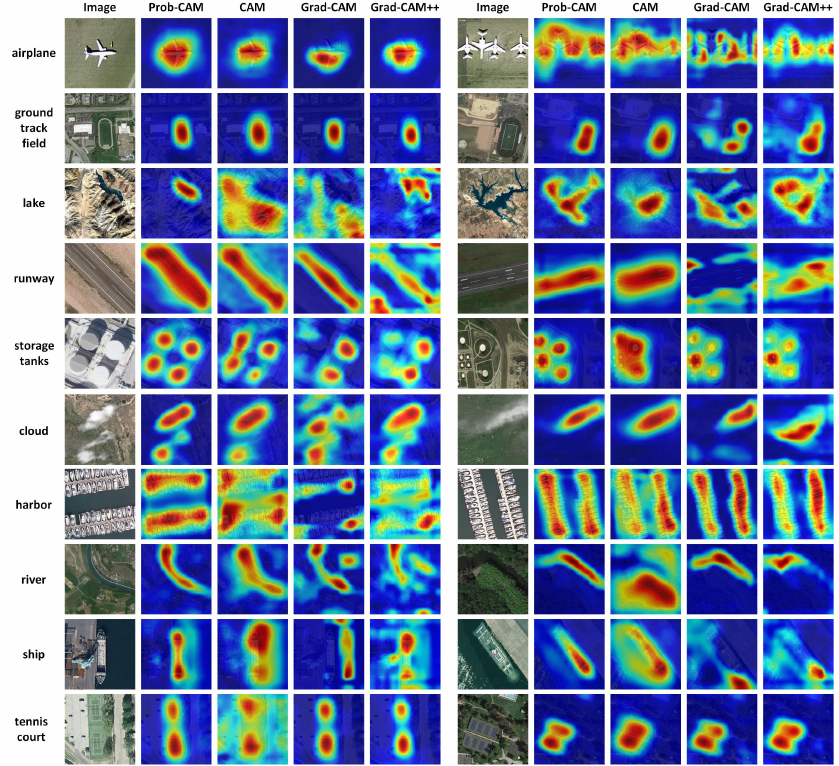
Figure 7. The explanation maps for sampled images from different scene class generated by Prob- CAM, CAM and Grad-CAM. They were all obtained on the last layer, which was the optimal explanation layer for the shown